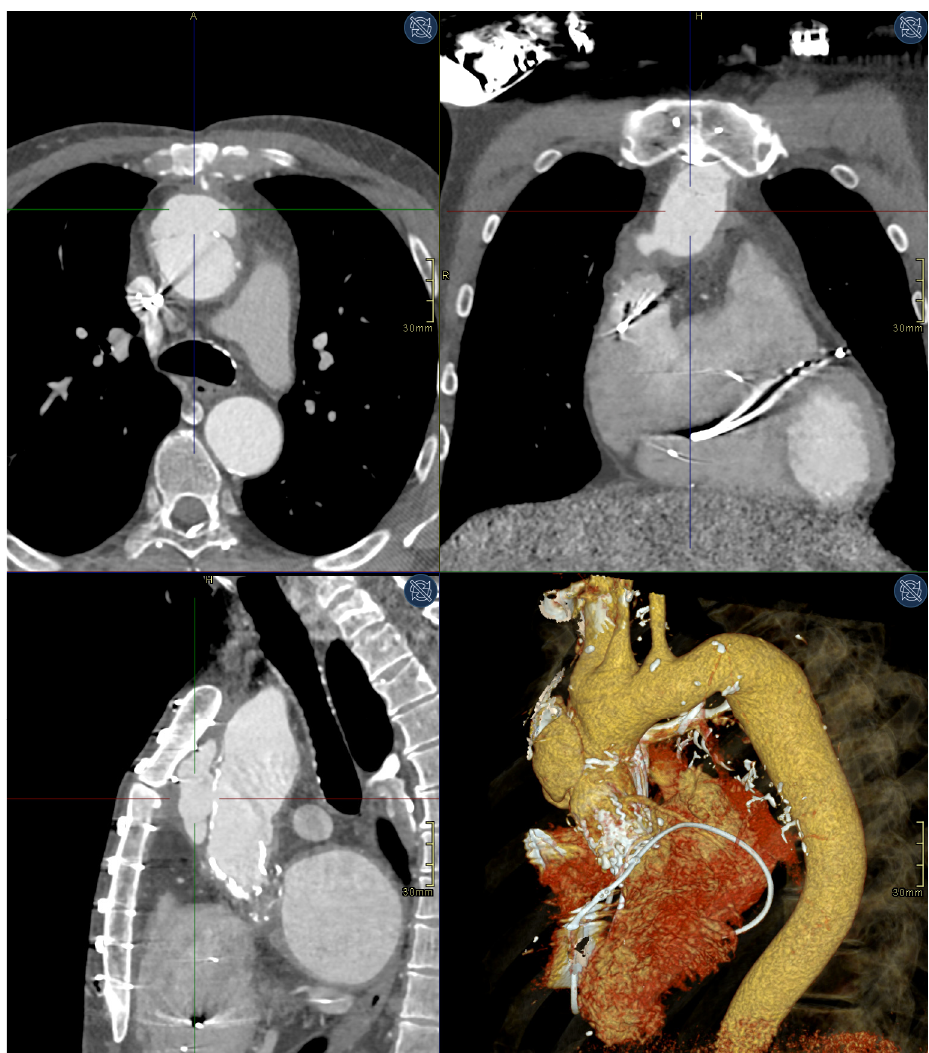
Figure 1. Preprocedural CTA showing a 58 × 55 × 30 mm pseudoaneurysm anteriorly in the ascend- ing aorta. Clockwise from left bottom: sagittal plane arterial phase CTA, axial plane arterial phase CTA, coronal plane arterial phase CTA, volume rendering technique (VRT) 3D representation CTA. After re-admission due to the asymptomatic ascending aortic pseudoaneurysm, a multidisciplinary team discussed the case and decided not to perform another open surgery but instead opt for a less invasive but technically extremely demanding hybrid thoracic endovascular aortic repair